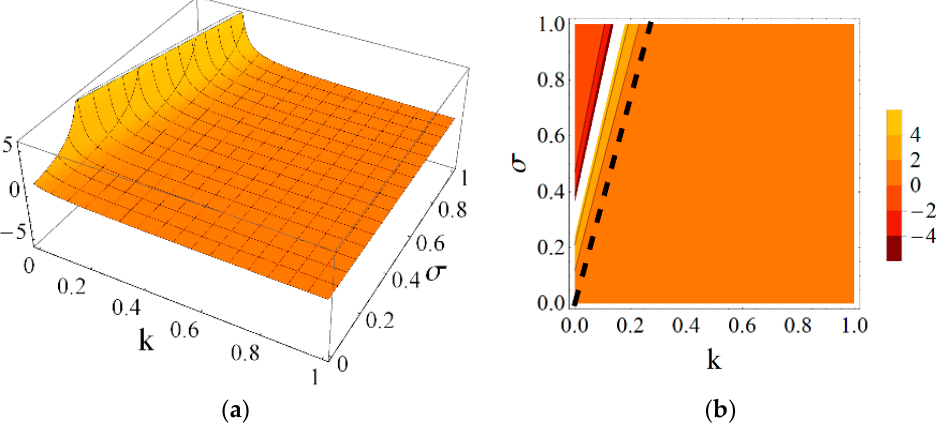
( b ) ( b ) νν = : ( a ) 3D plot; and ( b ) contour plot. Figure 10. Poisson’s ratio νν = : ( a ) 3D plot; and ( b ) contour plot. Figure 10. Poisson’s ratio Figure 10. Poisson’s ratio ν 13 = ν 23 : ( a ) 3D plot; and ( b ) contour plot. 2313 2313 Materials 2018 , 11 , x FOR PEER REVIEW 11 of 14